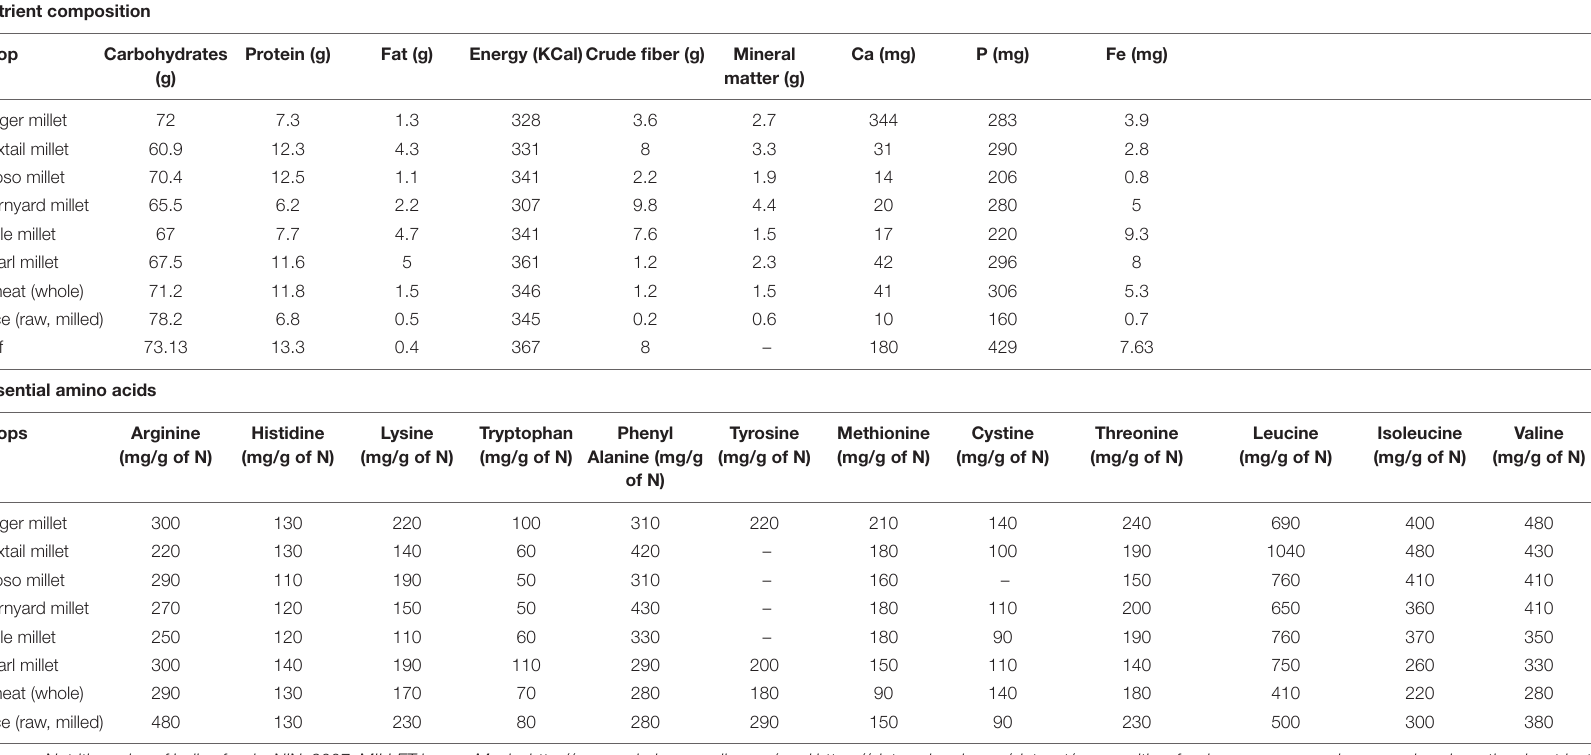
TABLE 2A | Nutritional profile of selected millets compared with those of wheat and